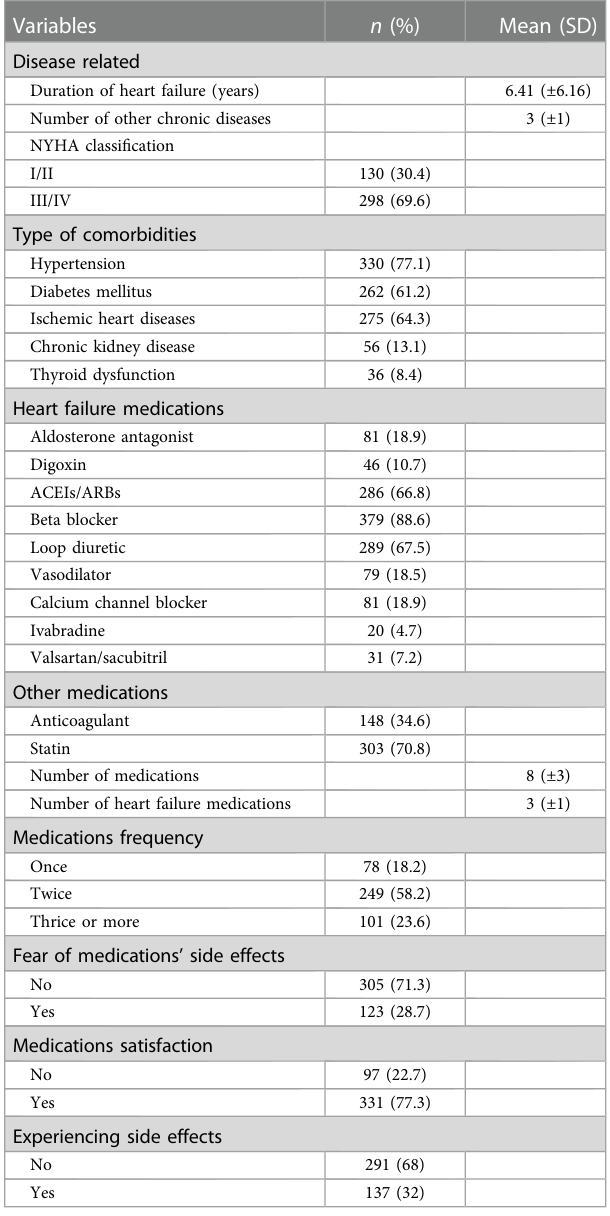
TABLE 2 Disease and medication characteristics of the study participants ( n =428).